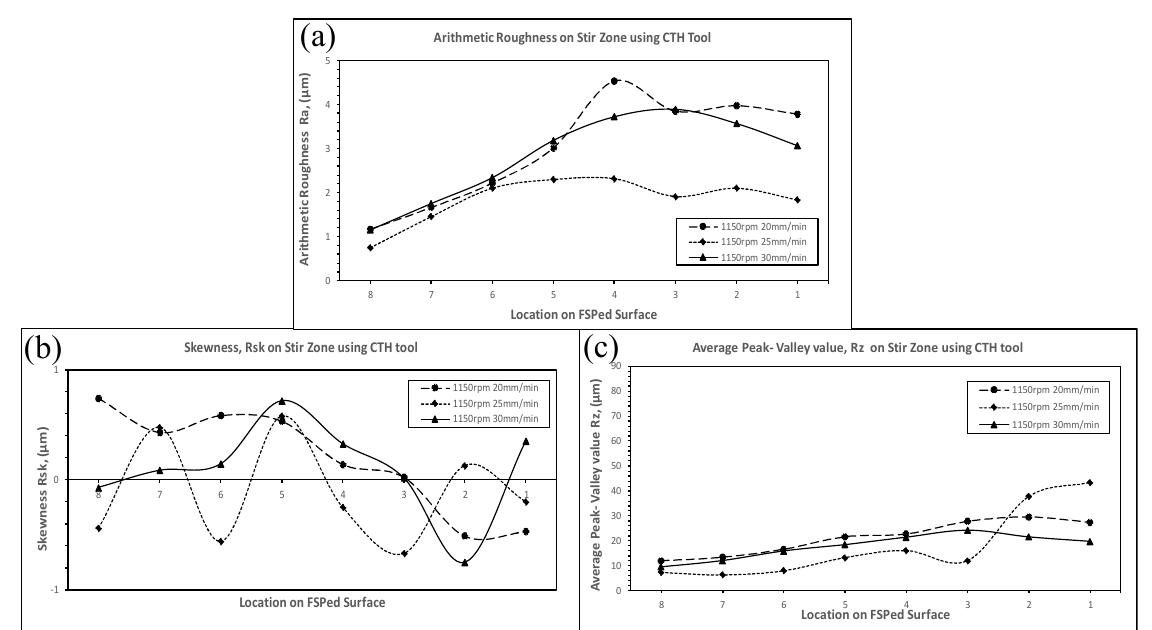
Figure 12. ( a ) Arithmetic roughness, Ra, ( b ) skewness, Rsk, and ( c ) average peak-valley, Rz, value for FSP using 1150 rpm and CTH tool at different feed rates.